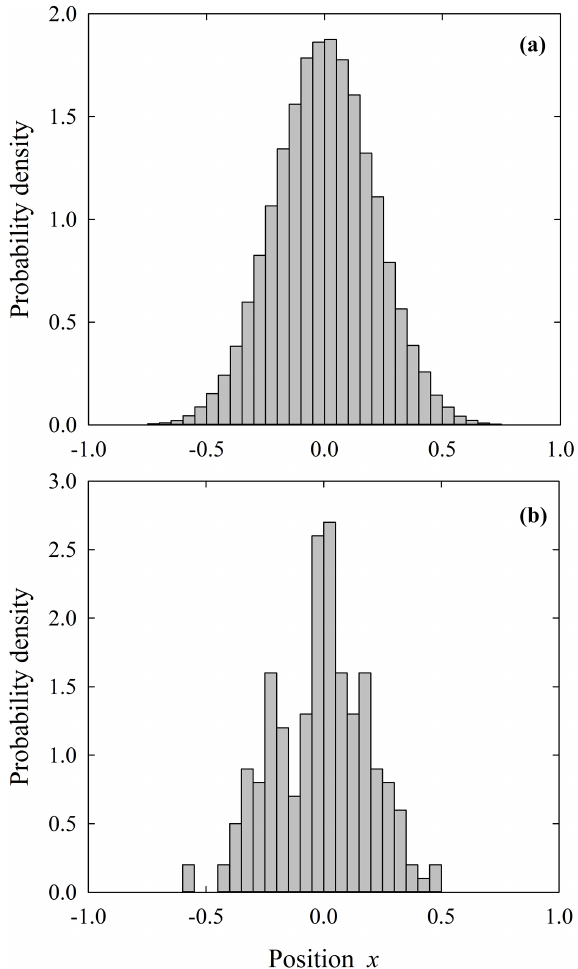
Figure A2. Histograms of particle positions x at time t for one system showing that (a) with a great number N of particles rep- resenting a continuum condition this histogram converges to the smooth Gaussian distribution in Fig. A1 as d x → 0; in this example N = 100000, and (b) with a modest number of particles represent- ing a rarefied condition this histogram is irregular and discontinu- ous; in this example N = 200.